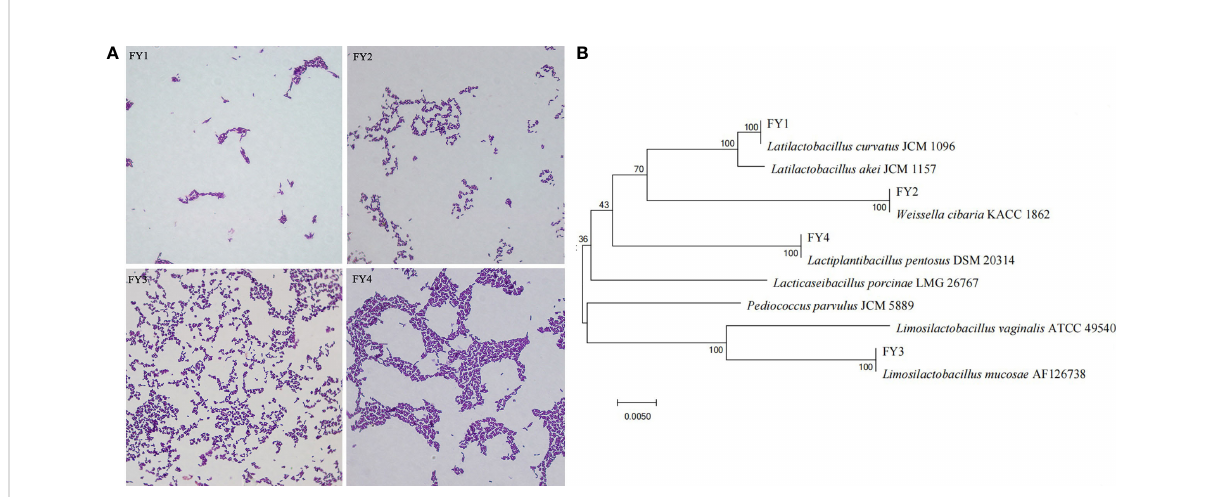
FIGURE 1 Phylogenetic tree of four isolates based on Neighbor-Joining distance analysis of 16S rRNA gene sequences. (A) The diagram shows the results of Gram staining for four isolates: FY1 ( L. curvatus ), FY2 ( W. cibaria ), FY3 ( L. mucosae ), and FY4 ( L. pentosus ). (B) Phylogenetic tree constructed by using a neighbor-joining method on the basis for 16S rRNA gene